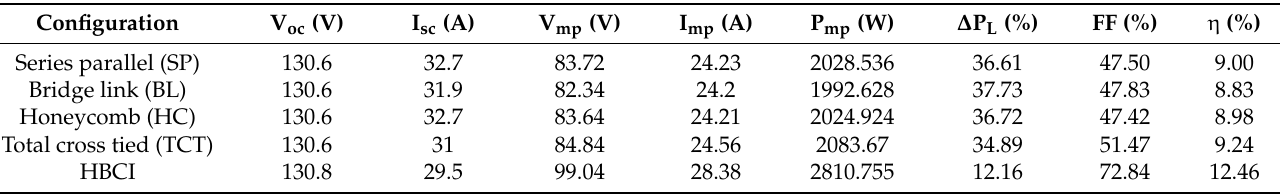
Table 5. Case 4: random